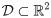
Model geometry.(A) To account for cell migration in the framework of a PRW, we cover the domain, D⊂R2, by a uniform lattice L={vk:⋃k=1NIvk⊃D} of non-overlapping hexagonal voxels, vk, of width h (or hexagon edge, a, h=3a). We denote by I={k=(kx,ky)T:vk∈L} the set of 2D indices, with cardinal, |I|=NI. The coordinates of the centre of voxel vk are denoted by qk=(qkx,qky)T. We assume that there is a constant supply of ECs to the domain, coming from the vascular plexus. These ECs enter the domain at fixed boundary voxels, defined as a set, IVP (coloured in green). (B) A detailed illustration of an individual voxel, vi. s = h−1(qj − qi) denotes a normalised vector of the migration direction between neighbouring voxels, vi and vj. There are at most 6 possible migration directions for each hexagonal voxel. Each migration direction, s, can be characterised by an equivalent angle interval [ϕmins,ϕmaxs].